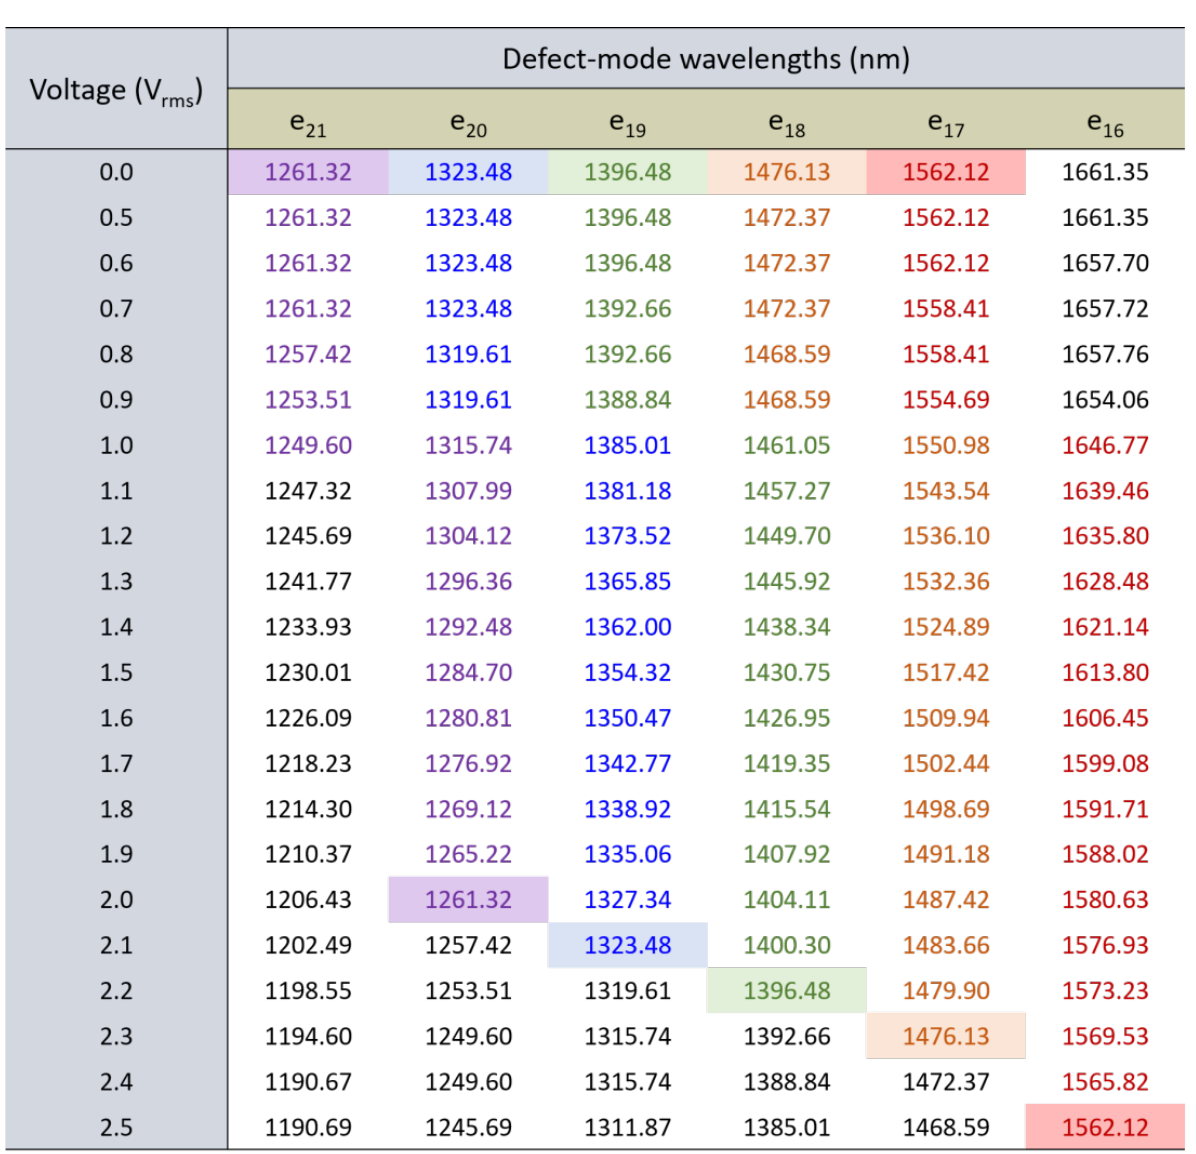
Figure 8. Spectral tunability of the e -mode peaks (e 16 to e 21 ) under various amplitudes of an electrical stimulus. The applied voltage is increased from V = 0 to 2.5 V rms by a 0.1-V rms increment.